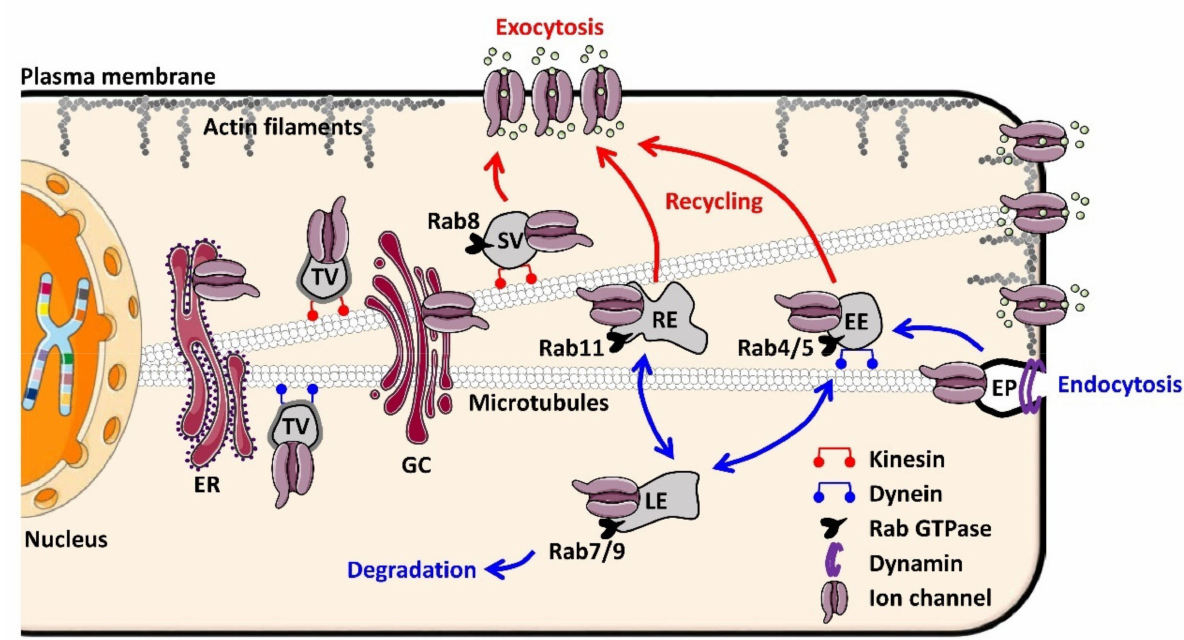
Figure 1. General diagram of the different steps and regulators involved in ion channel trafficking. Ion channels are directed to the plasma membrane via the anterograde and recycling pathways (red arrows). Due to their topology, proteins with multiple transmembrane domains, such as ion channels, have their C - and N -terminal domains exposed on the cytoplasmic side during transport. Endocytosis is ensured by membrane bending and fission of the endocytosis pit, mainly by dynamin (purple). Internalization signals (blue arrows) lead to degradation or recycling. Rab GTPases regulate specific steps of trafficking in the cytoplasm. Molecular motors, such as kinesin and dynein, ensure the transport of vesicles along microtubules, respectively, in the anterograde and retrograde directions. The molecular motors involved in transport along actin filaments are myosins: myosin V in the anterograde direction, myosin VI in the retrograde direction. Abbreviations: EE: early endosome; EP: endocytosis pit; ER: endoplasmic reticulum; LE: late endosome; GC: Golgi complex; RE: